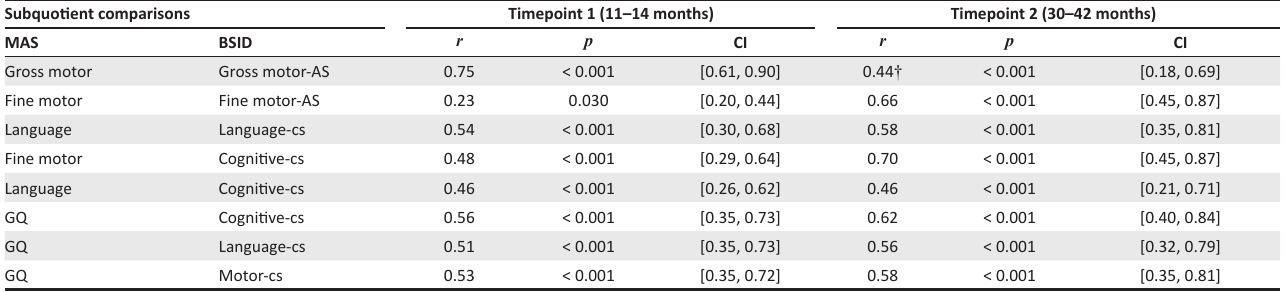
TABLE 3: Pearson correlation between Molteno Adapted Scales general and subquotient scores and Bayley Scale of Infant and Toddler Development-3rd edition composite and scaled scores. Subquotient